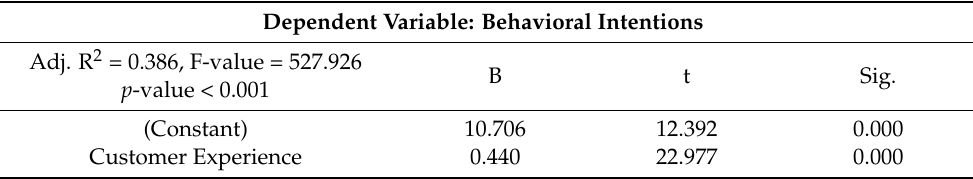
Table 7. Step 3. Third simple regression equation of the mediation analysis.